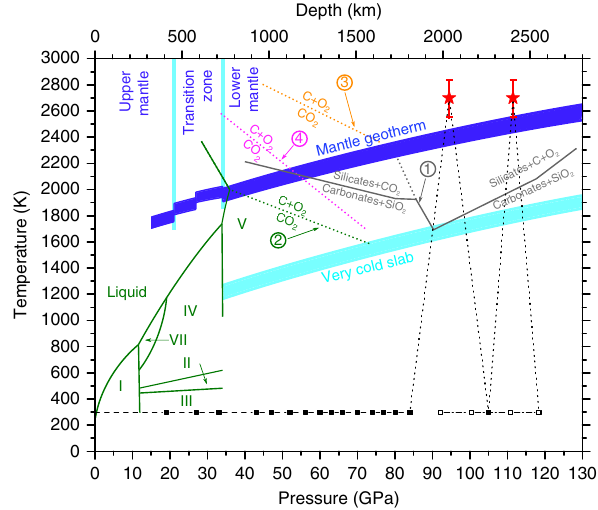
Fig. 1 Experimental pressure-temperature pathway and the phase diagram of CO 2 . The plot shows the relevant parts of the phase diagram of CO 2 and the CO 2 breakdown lines reported in previous studies. 1 – Phase boundaries in the MgCO 3 -SiO 2 system after ref. 9 (gray lines); the dotted gray line corresponds to the breakdown of CO 2 . 2 – Phase relations and melting curves (solid green lines) and CO 2 breakdown line (dotted green line) after ref. 8 and references therein; phase boundaries of CO 2 -II and CO 2 -III after ref. 12. 3 – Breakdown reaction after ref. 27 (dotted brown line). 4 – Breakdown reaction after ref. 28 (dotted purple line). The dark blue line corresponds to the adiabatic temperature pro fi le in the mantle geotherm after ref. 50 , the light blue line to the depth-temperature path in ref. 9 as referred to a very cold subduction slab. The dashed black line follows isothermal compression up to ~ 85 GPa, the dotted black lines show the putative heating and cooling route, the dash-dot line represents decompression run. Squares denote experimental points at which XRD patterns were measured ( fi lled on compression, empty on decompression). Red asterisks mark P-T conditions at laser heating cycles with the error bars at the estimated uncertainty of ± 150 K, as explained in the Methods